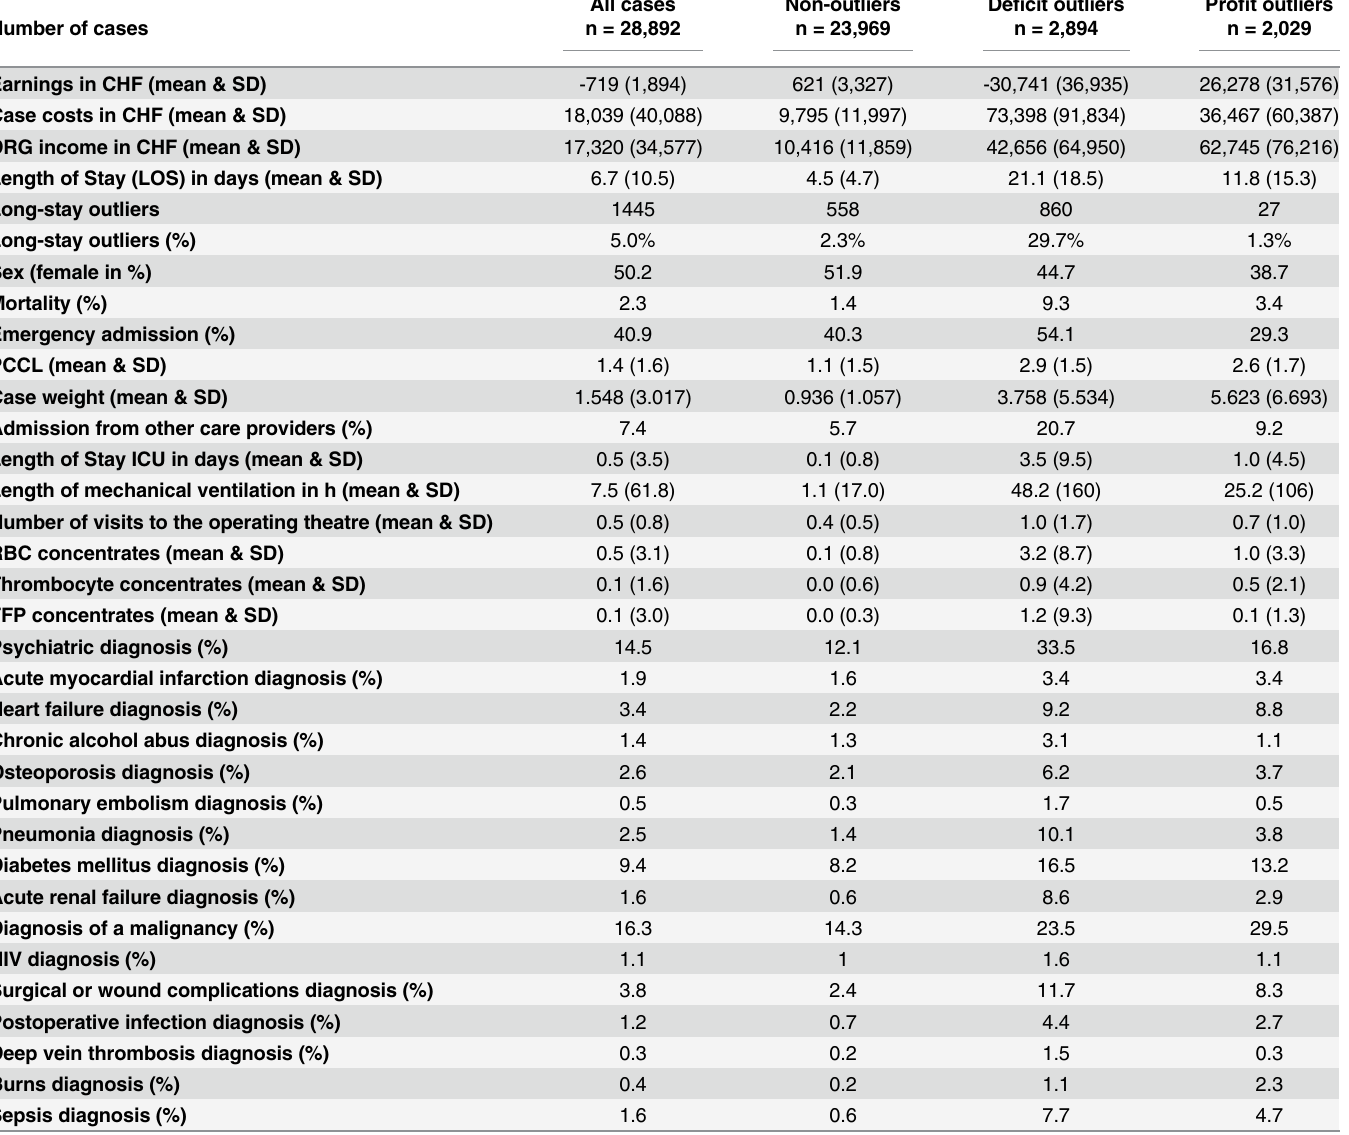
Table 1. Sample characteristics. Outliers selected with the IQR